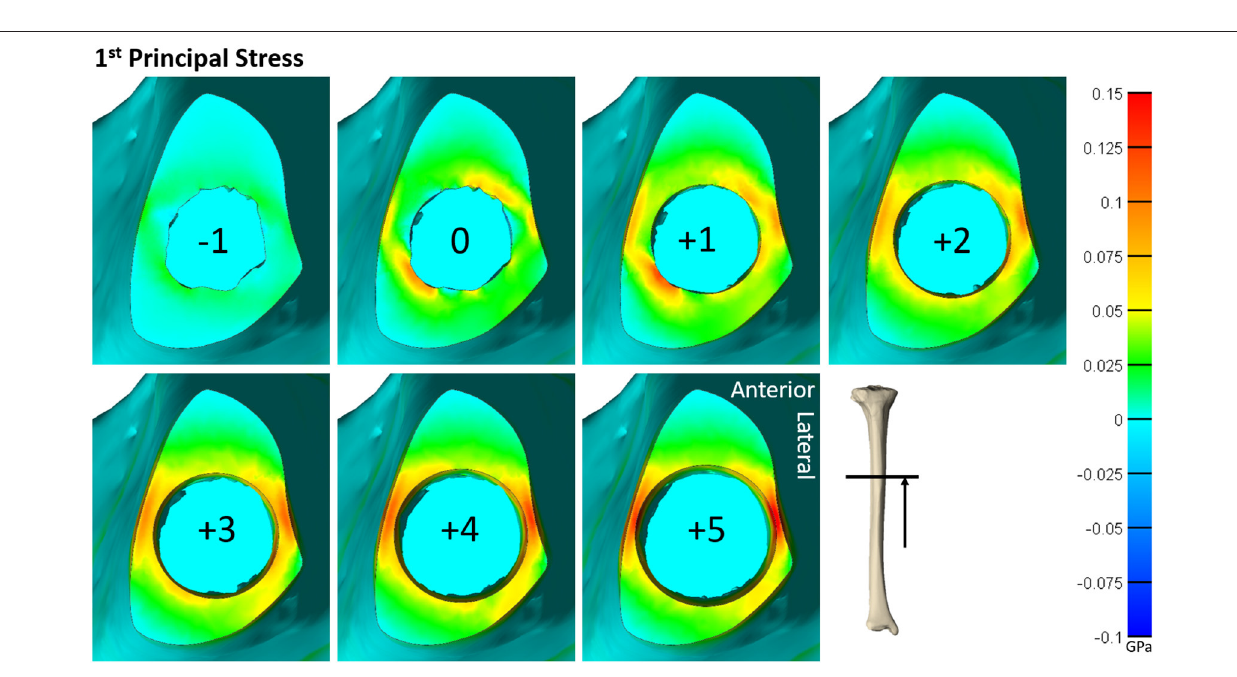
respectively (26). These results do not provide a direct measure of stress from radial dilation of the bone, since both sides are fixed, but they provide a fracture risk threshold in the correct loading direction of observed fractures. Other tests that